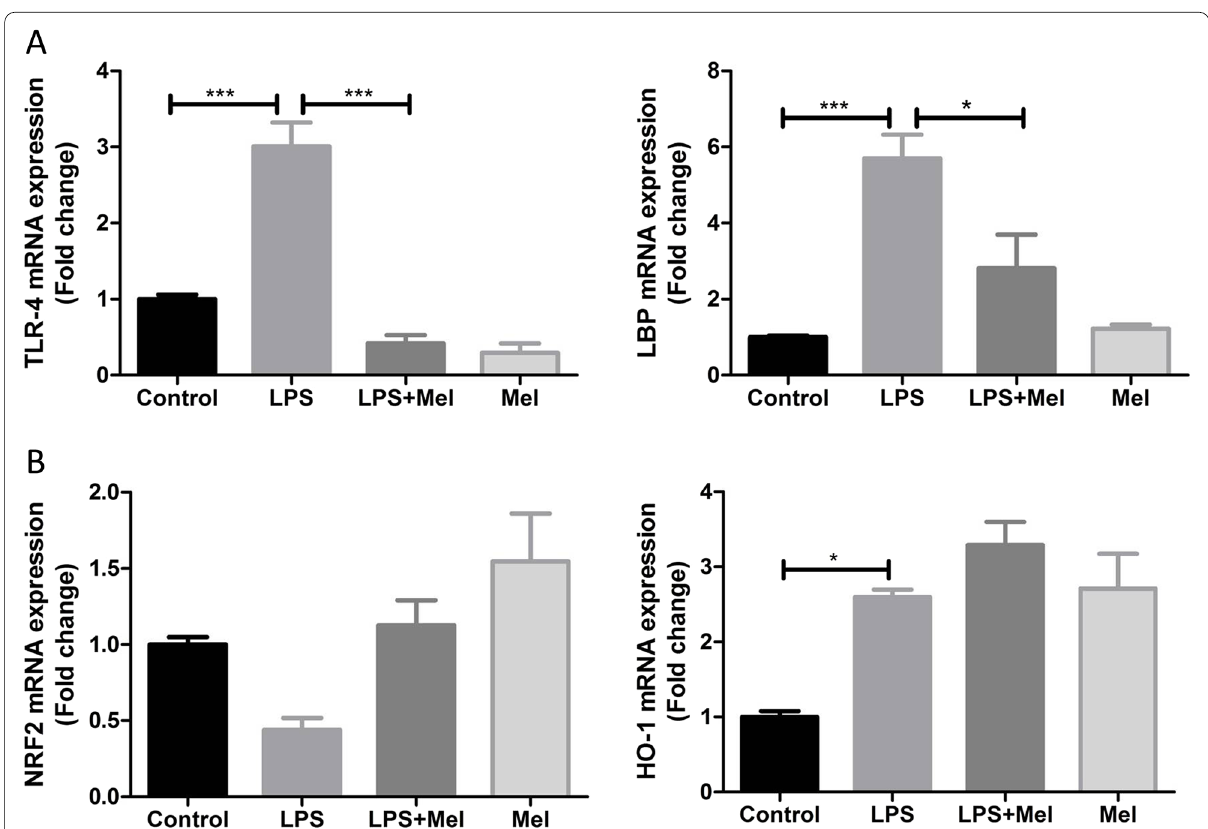
Fig. 2 mRNA levels of a Tlr-4 and Lbp and b Nrf2 and Ho-1 following lipopolysaccharide (LPS) and/or melatonin (Mel) treatments to adipose-derived MSCs. Data expressed as mean S.E.M. for n 3. * p < 0.05, ** p < 0.01, and *** p < ± =